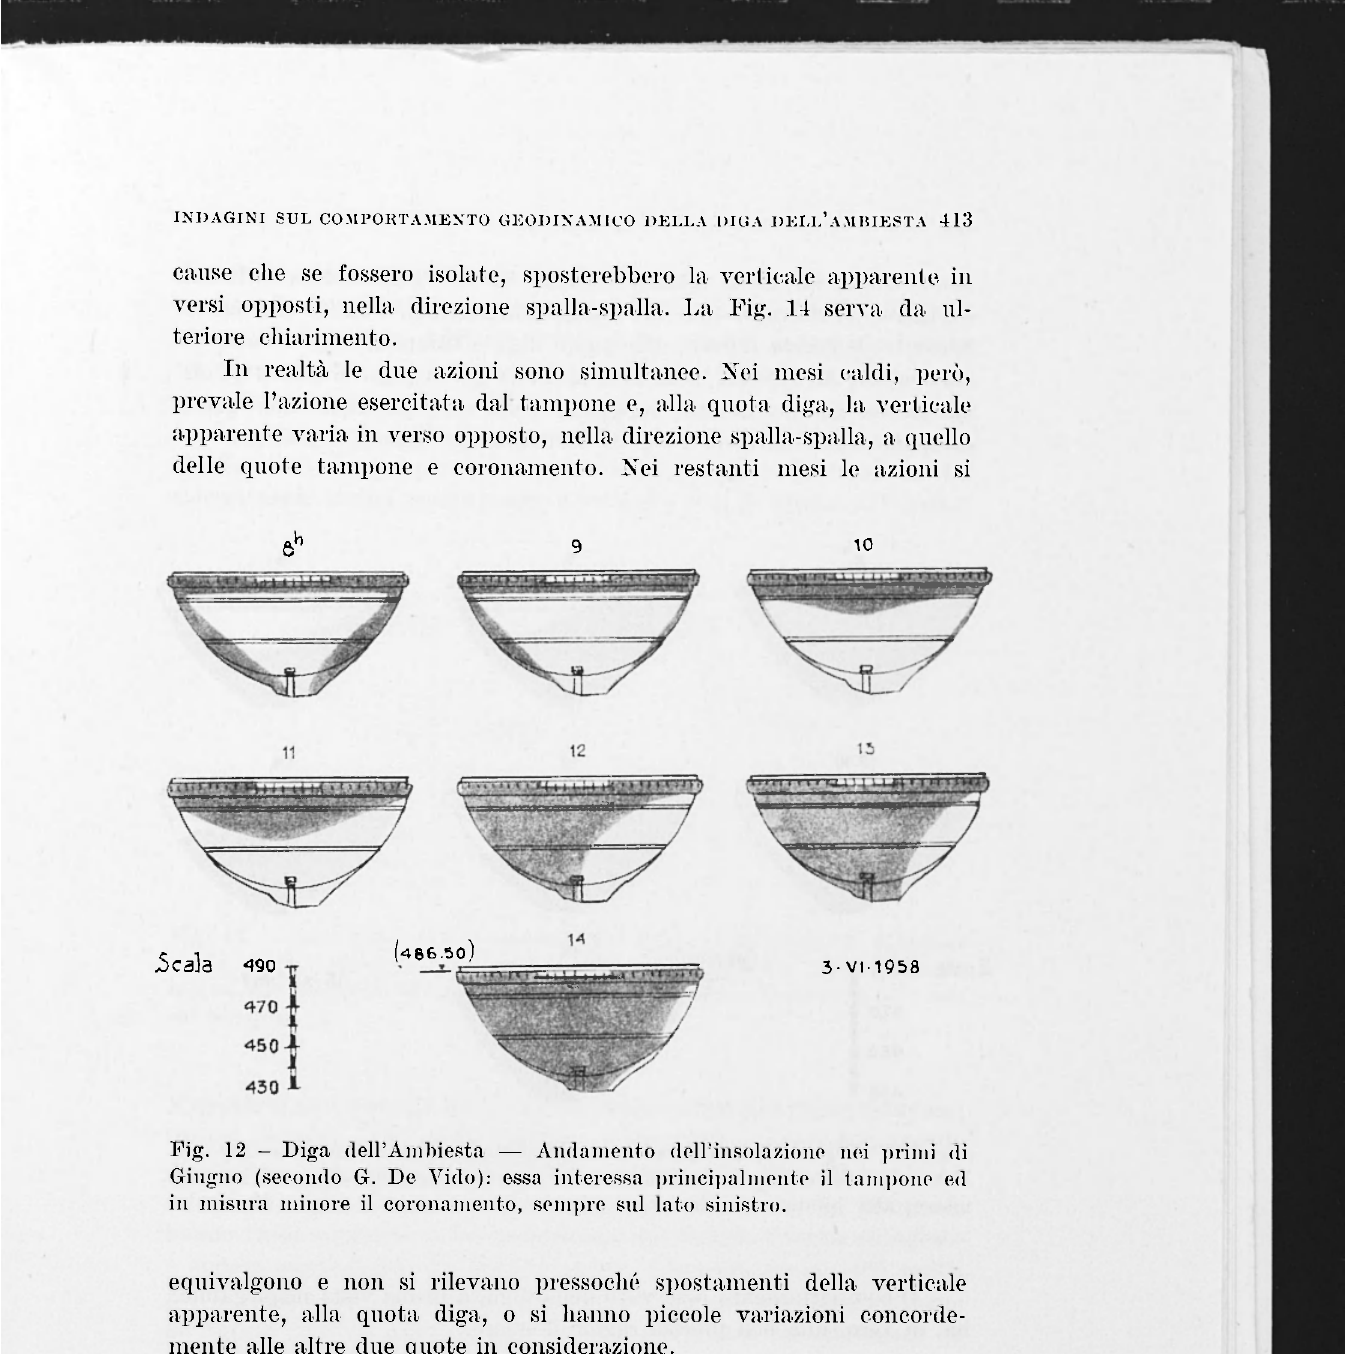
Fig. 12 - Diga dell'Ambiesta — Andamento dell'insolazione nei primi di Giugno (secondo G. De Vido): essa interessa principalmente il tampone ed in misura minore il coronamento, sempre sul lato